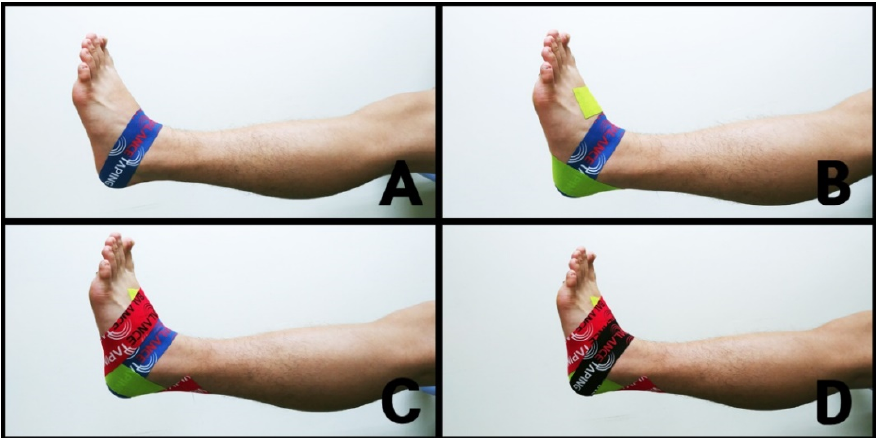
Figure 3. Ankle balance taping (ABT): ( A ) taping was applied from the dorsal center of the talus bone to the calcaneus bone; ( B ) taping was applied from 5 cm above the medial malleolus and passed through the lateral calcaneus below the subtalar joint; ( C ) taping was applied from 5 cm above the lateral malleolus and passed through the medial calcaneus below the subtalar joint; ( D ) taping was reapplied on top of the area covered by the initial taping.